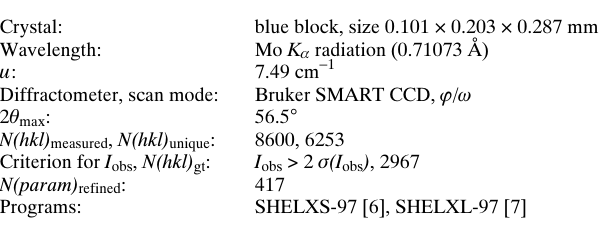
Table 1. Data collection and